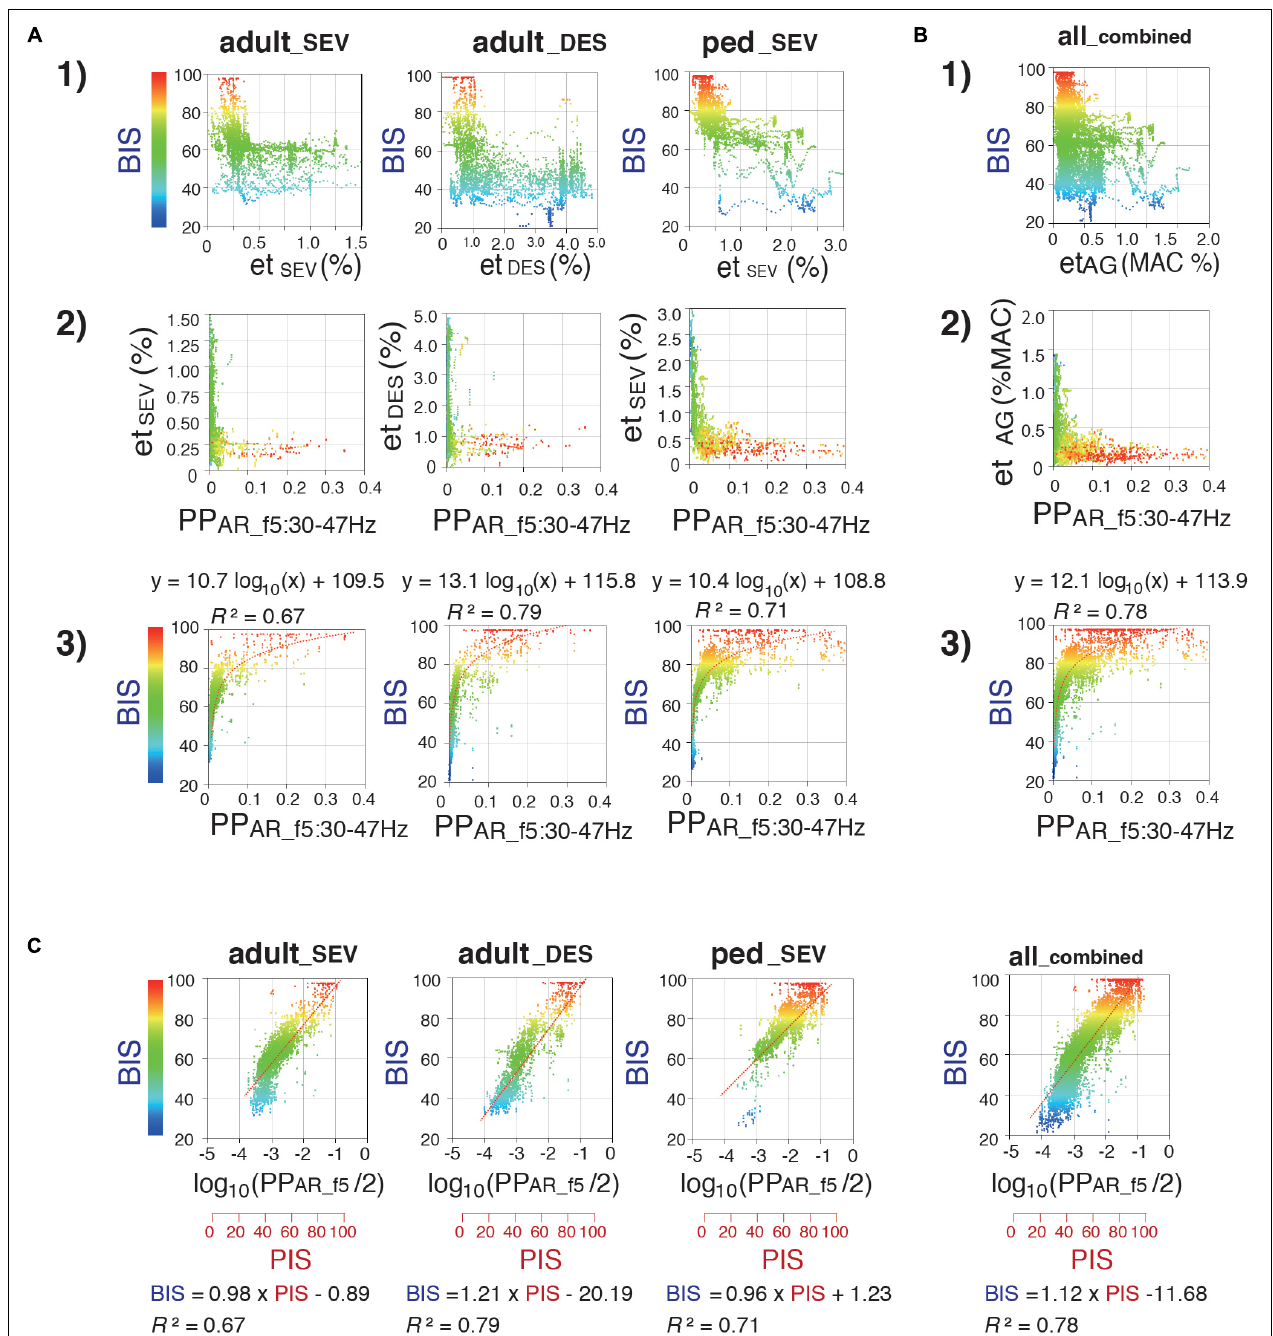
FIGURE 6 | Relationship between Poincaré plot-area ratio at f5:30–47 Hz (PP AR _ f 5 ), BIS, and et AG . Scatter plots display correlations between (1) et AG (%) and BIS, (2) PP AR _ f 5 and et AG (%), and (3) PP AR _ f 5 and BIS (A) in the adult _ SEV , adult _ DES , and ped _ SEV groups and (B) in the all _ combined group. (4) 3D-scatter plot between end-tidal concentrations (%MAC), PP AR _ f 5 , and BIS in the all _ combined group. (C) Semi-logarithmic scatter plots between Poincaré plot-integrated score (PIS) and BIS in the adult _ SEV , adult _ DES , ped _ SEV , and all _ combined groups. PIS = 25 × log 10 (PP AR _ f 5 )+112.5. Minimum alveolar concentration at 50% (MAC) values of sevoflurane and desflurane were calculated by using 1.71 and 7.25, respectively. adult _ SEV , adult patients anesthetized with sevoflurane ( n = 20); adult _ DES , adult patients anesthetized with desflurane ( n = 20); ped _ SEV , pediatric patients anesthetized with sevoflurane ( n = 20); all _ combined , all patients from the three groups ( n = 60). RINEARN Graph 3D (free software ver 5.6, https://www.rinearn.com, RINEARN, Kyoto, Japan) was used for the creation of graphs. BIS, bispectral index; et AG , end-tidal anesthetic gas; et DES , end-tidal sevoflurane concentration; et SEV , end-tidal sevoflurane concentration; PIS, Poincaré plot-integrated score; PP AR _ f 5 , Poincaré plot-area ratio at f5:30–47 Hz; R 2 , coefficient of determination.